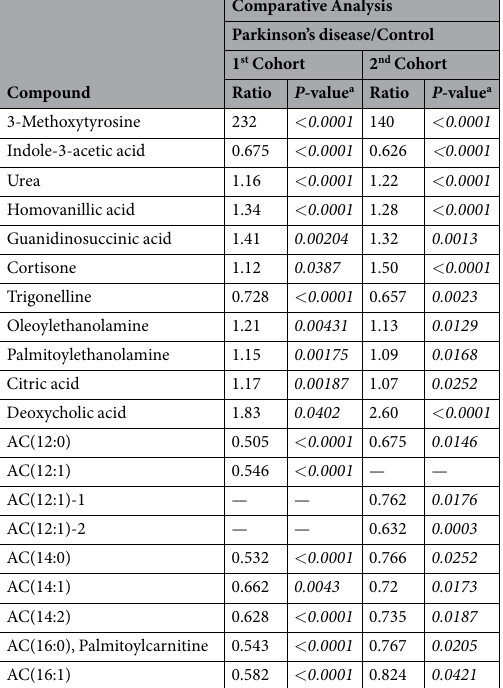
Table 2. Statistically significant metabolites in Parkinson’s disease vs controls in both cohorts. Abbreviations: AC = acylcarnitine. a P -value obtained by Wilcoxon’s test, comparing between PD and